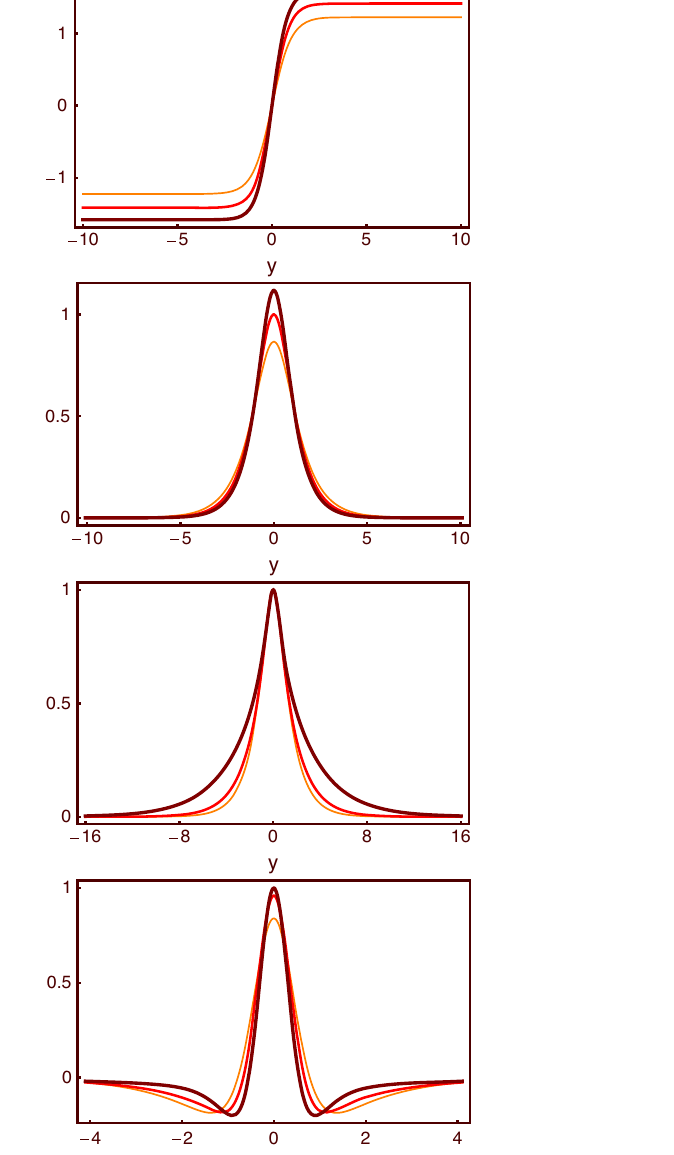
Fig. 2 From top to bottom, we depict the solutions φ( y ) and χ( y ) in Eq. (17), the warp factor associated to the warp function in Eq. (19) and the energy density (11) corresponding to these solutions for r = 0 . 1 with α = 0 . 5 , 0 . 75 , 1. The line thickness and color darkness increase as α